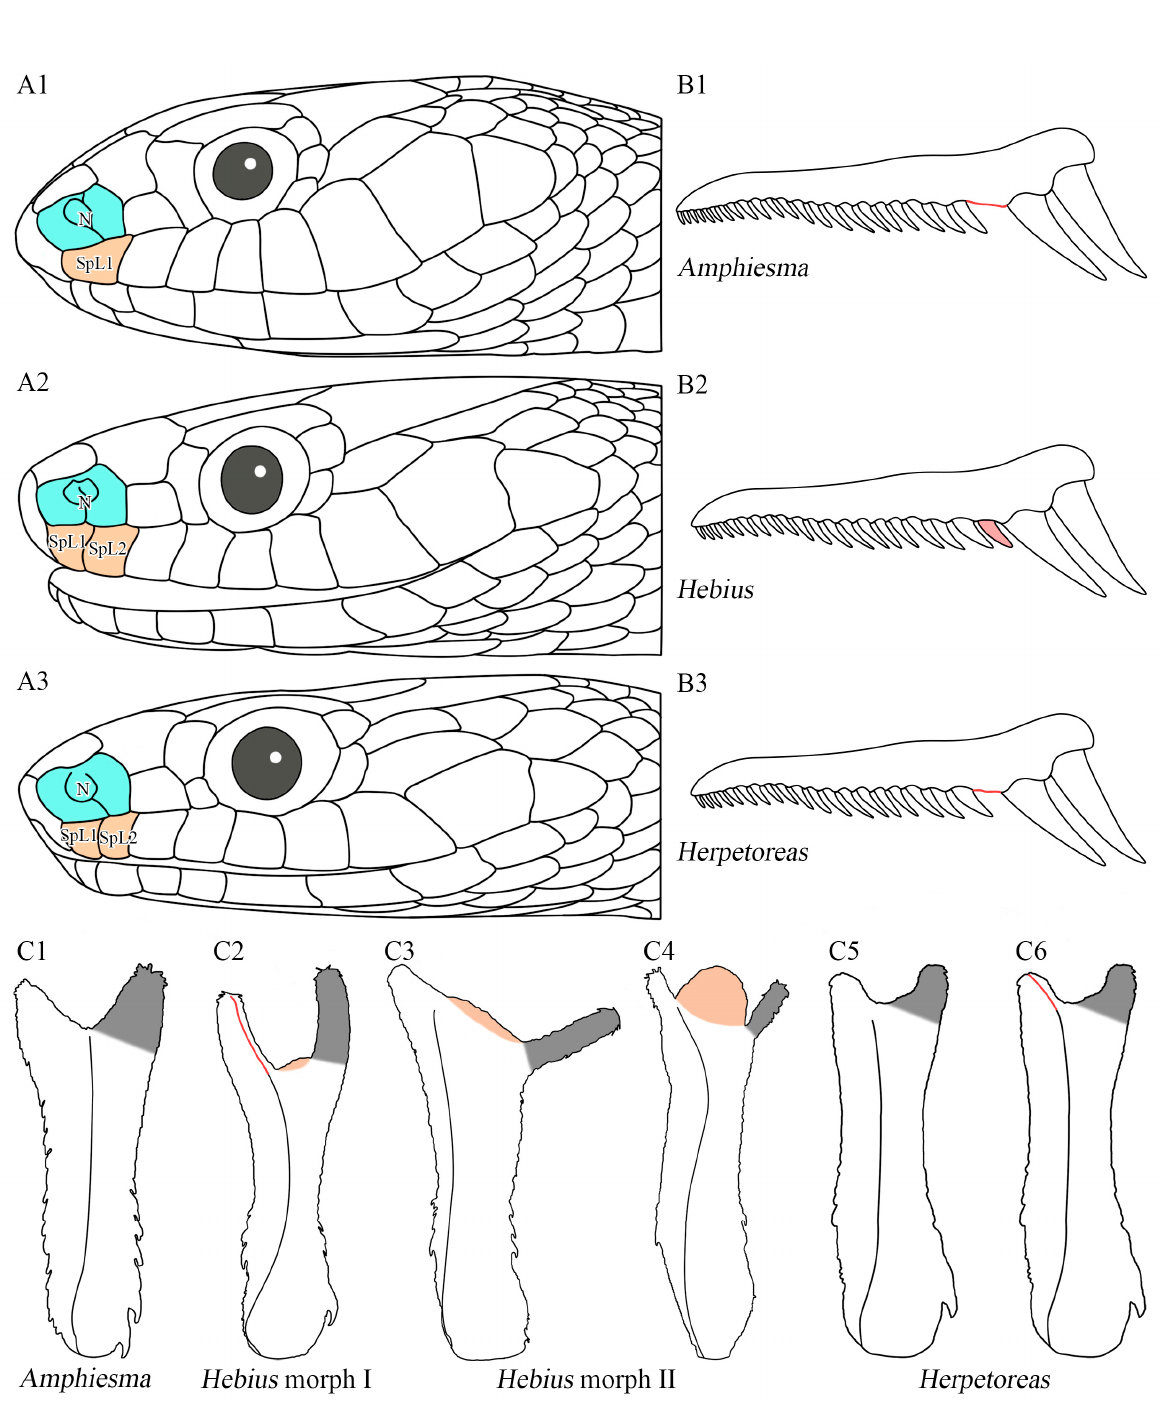
Figure 13. Comparisons of morphological features of Amphiesma sensu lato , showing diagnostic characters among the genera Amphiesma , Hebius , and Herpetoreas . ( A ) lateral head view, showing different numbers of supralabials (SpL, in orange) in contact with nasals (N, in blue) in different genera: ( A1 ). Amphiesma stolatum , YBU 12081A; ( A2 ). Hebius boulengeri , SYS r001680; ( A3 ). Herpetoreas tpser sp. nov. , CIB 107855. ( B ) schematic diagrams of maxillary teeth and diastema (in red) in different genera: ( B1 ). Amphiesma , diastema present; ( B2 ). Hebius , diastema absent; ( B3 ). Herpetoreas , small diastema present. ( C ) schematic diagrams of hemipenial morphology in different genera, showing differences in direction and the position of the distal end of sulcus spermaticus (in red); the area of apical naked areas (in orange); and the condition of the left lobe of hemipenis (in grey). Not to scale. Line drawings by Jin ‐ Long Ren.